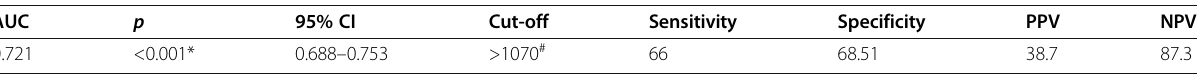
Table 1 Diagnostic performance of non-contrast T1 mapping for identifying myocardial fibrosis in patients with cardiomyopathy, ROC curve results, and validity (AUC, sensitivity, specificity) AUC p 95% CI Cut-off